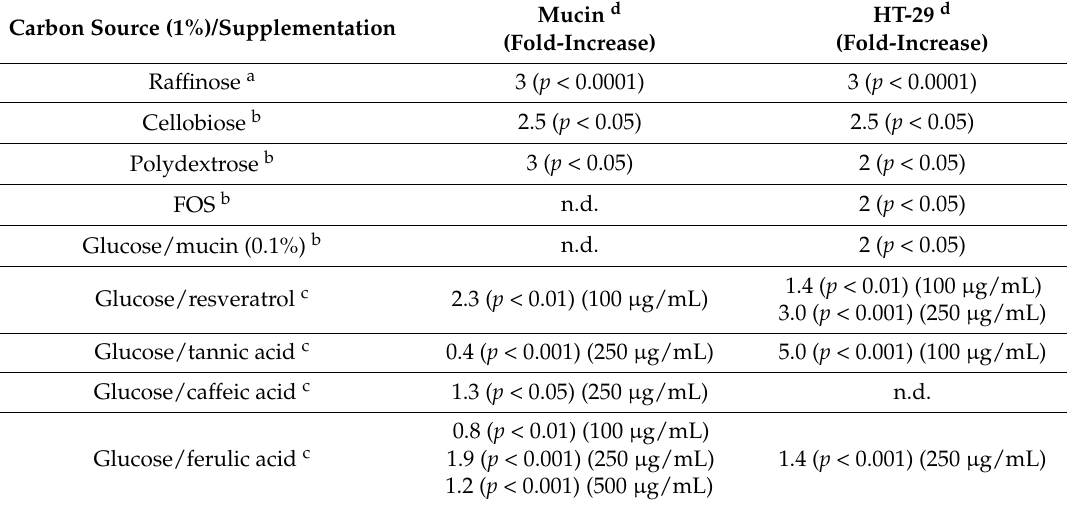
Change in adhesive capacity onto mucin coating and HT-29 cells, respectively, of Lactobacillus acidophilus NCFM grown on different carbon sources and supplements as compared to growth on